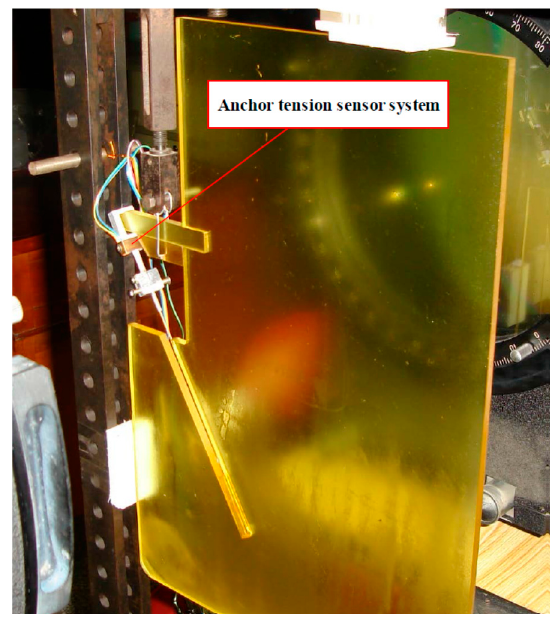
Figure 4. Anchor tension sensor.